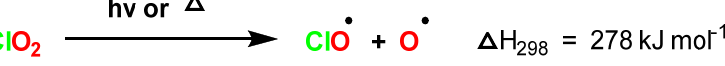
Figure 19. Homolysis of ClO 2 by thermal route or with irradiation.